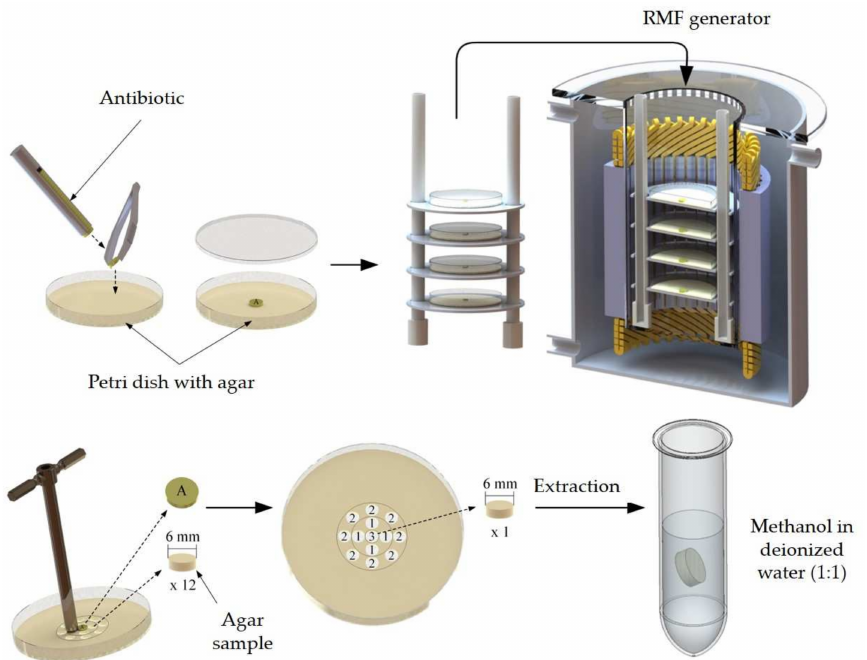
Figure 8. Schematic presentation of the analysis of the impact of RMF on the diffusion of antibiotics in the agar medium. 1—agar sample from the proximal zone (zone 1); 2—agar sample from the distal zone (zone 2); 3—agar sample under the antibiotic paper disc (zone 3); A—antibiotic paper